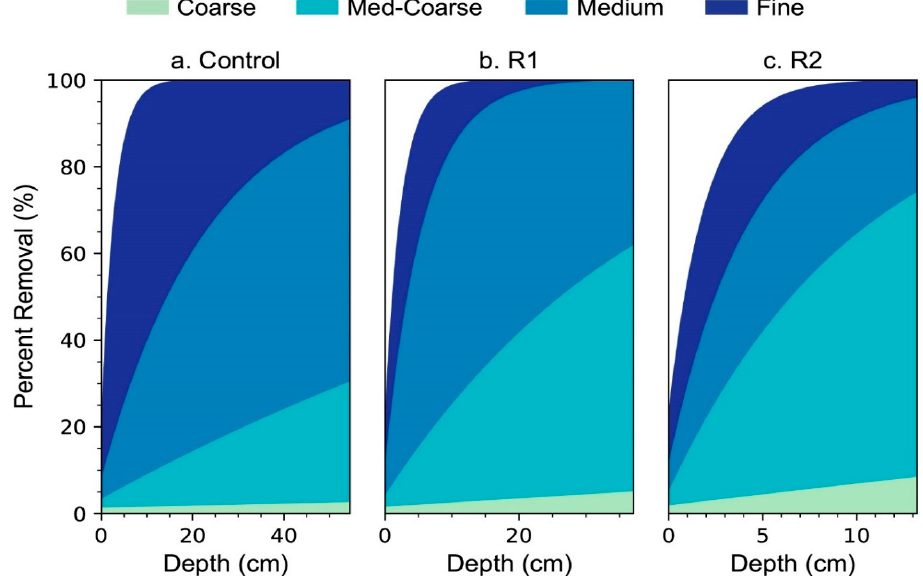
Figure 8. Modeled percent removal of MS2 by depth at varying sand media for ( a ) a traditional BSF design (control); ( b ) a 40% reduced-height design (R1); and ( c ) a 70% reduced-height design (R2). Color fills are used to represent a range between given media such as that between fine and medium sand. Note the x-axis scales are different.